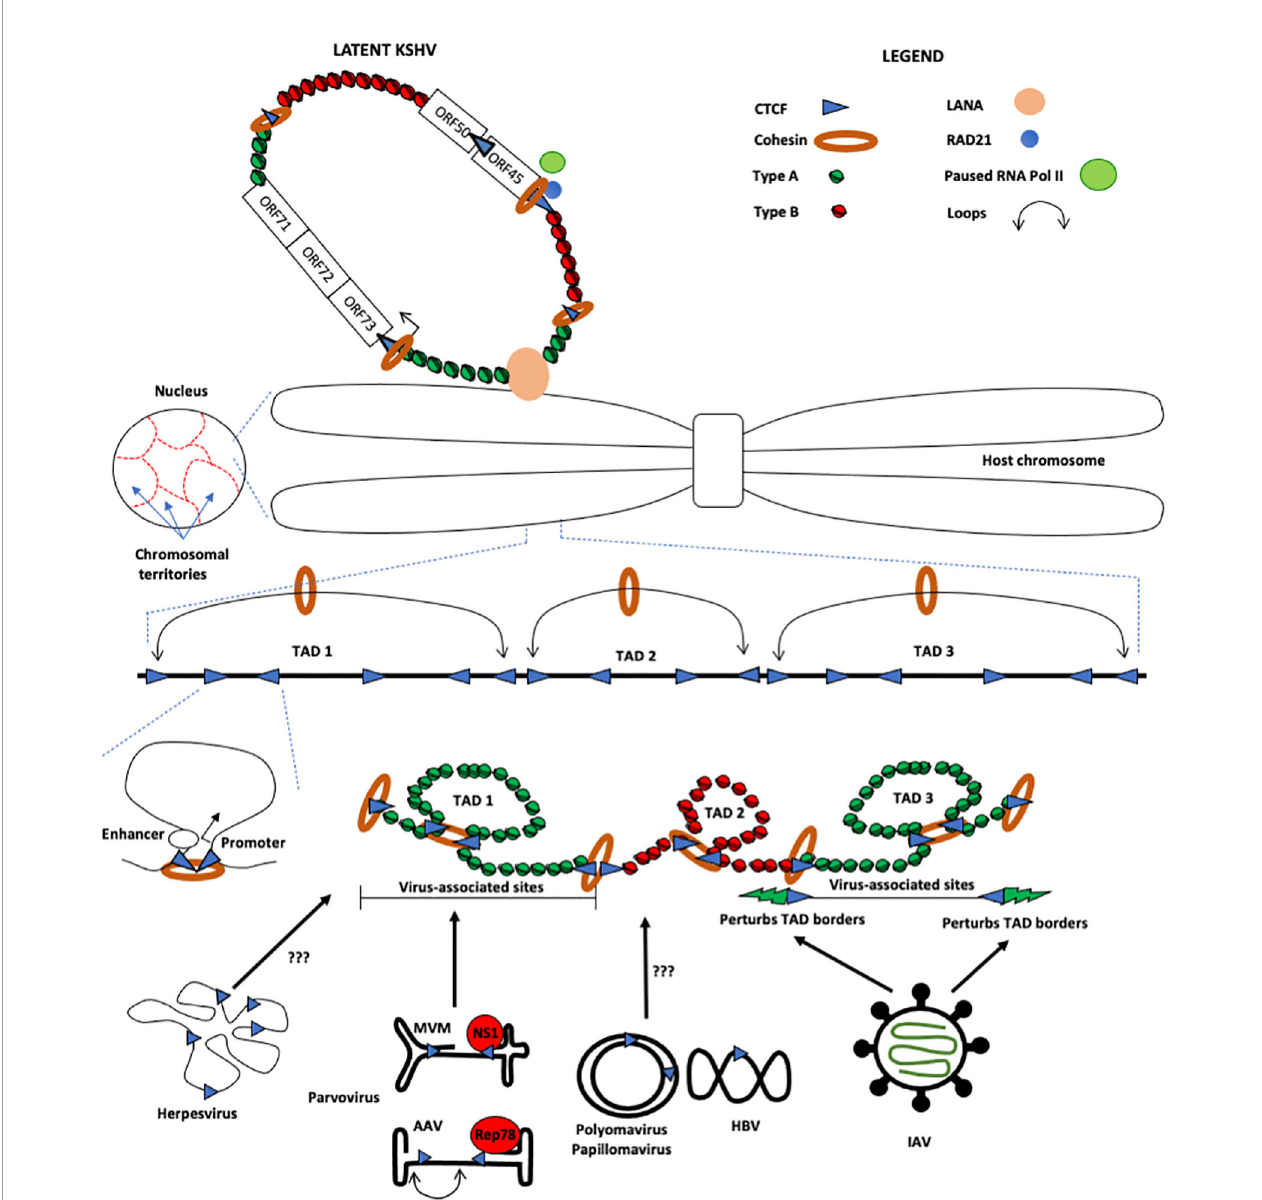
FIGURE 1 | Schematic of how host chromosomes occupy nuclear territories and fold in- cis to form Topologically Associating Domains (TADs). These TADs are built up of multiple smaller cis -loops such as promoter-enhancer loops (as shown). These TADs are formed by interactions between convergent CTCF (blue triangle) and Cohesin (orange ring) bound regions, which modulate the TAD architecture and demarcate the boundaries between Type A-associated chromatin (green nucleosomes) from Type B-associated regions (red nucleosomes). Upon infection, In fl uenza A Virus (IAV) localizes to distinct TAD regions, which perturb the border between Type A and Type B chromatin (shown as green lightning), leading to eviction of cohesin from the borders and Type A chromatin into Type B. On the other hand, the protoparvovirus Minute Virus of Mice (MVM) localizes to distinct nuclear sites containing Topologically Associating Domains (TADs) that contain Type A chromatin (depicted in green histones). The borders between adjacent TADs are maintained by architectural proteins such as CTCF and Cohesin. However, in spite of the identi fi cation of CTCF binding sites on small DNA viruses (HBV, HPV, polyomaviruses etc) and herpesviruses, the mechanism of how they interact with host chromatin architecture remains to be elucidated. Also depicted (top, left) is Kaposi ’ s-sarcoma-associated herpesvirus (KSHV), which persists in latent form as chromatinized episomes that are tethered to host chromosomes by the latency associated nuclear antigen (LANA). CTCF, often along with Cohesin, bind the latent KSHV genome at many distinct sites (note that for simplicity, only a few are shown). CTCF/Cohesin are important boundaries between transcriptionally active (green nucleosomes) and silent (red nucleosomes) regions and are additionally important for coordinating physical interactions among the latency control region and the promoter regulatory region encoding the lytic immediate early protein RTA (ORF50; not